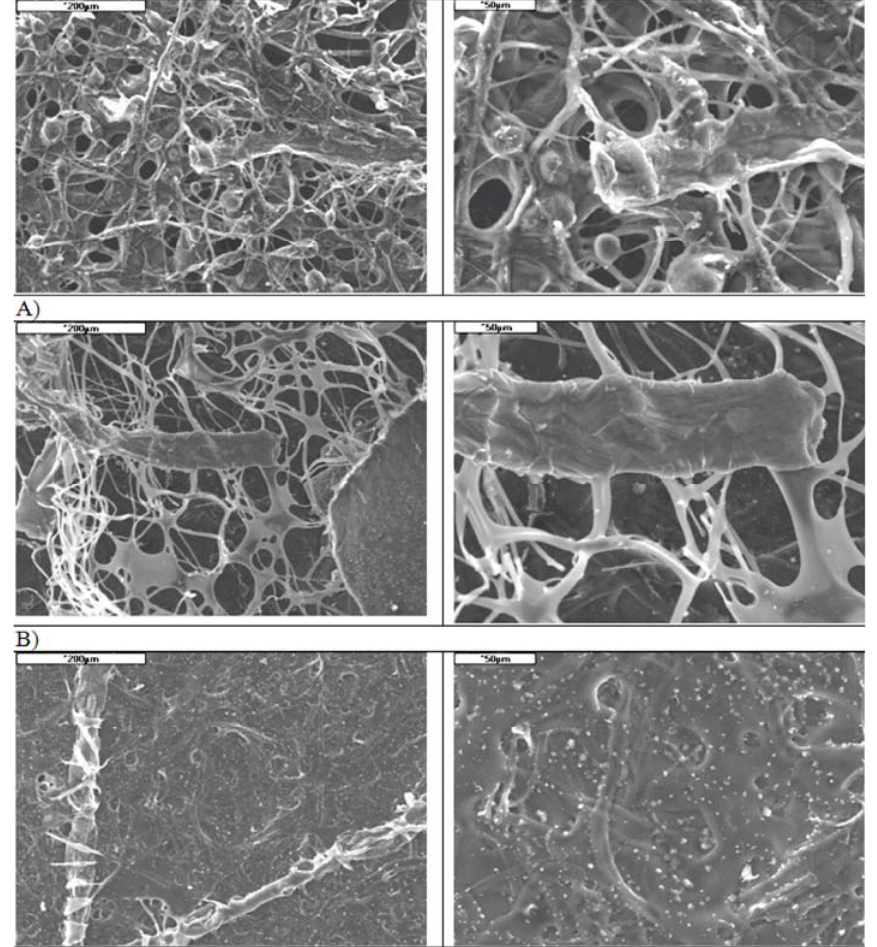
Figure 10. Microstructure of PCL/ZA:CA composite before and after incubation in PBS and SBF: ( A ) before incubation, ( B ) after incubation in PBS, ( C ) after incubation in SBF, ( D ) EDS analysis after incubation in